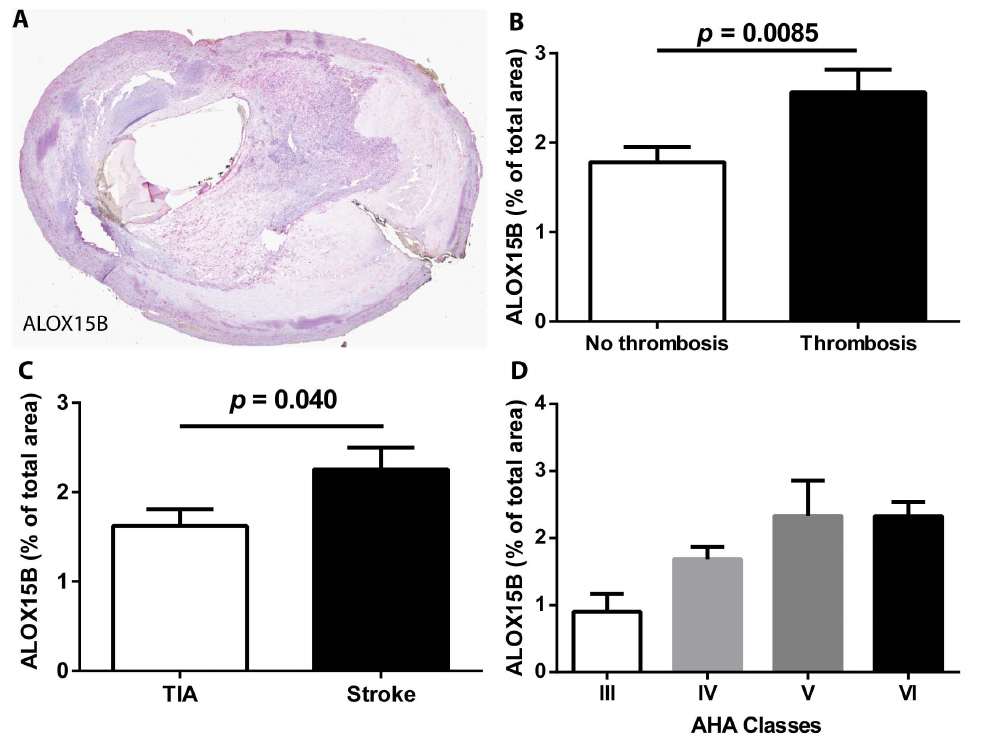
Figure 1. ALOX15B is present in atherosclerotic plaques. Serial sections of atherosclerotic plaques from the carotid artery of patients with symptomatic carotid artery stenosis (n=120) were stained with antibodies against ALOX15B and counterstained with Mayer’s hematoxylin. A representative section is shown in ( A ). ( B ) ALOX15B staining in plaques with thrombosis (n=46) and without thrombosis (n=74). ( C ) ALOX15B staining in plaques from patients diagnosed with stroke (n=62) or TIA (n=31). ( D ) ALOX15B staining in plaques classified according to AHA classes: III n=5; IV n=38; V n=18; VI n=59 (AHA class VI indicates complicated lesions with ruptured fibrous cap and/or surface thrombus). Data are mean 6